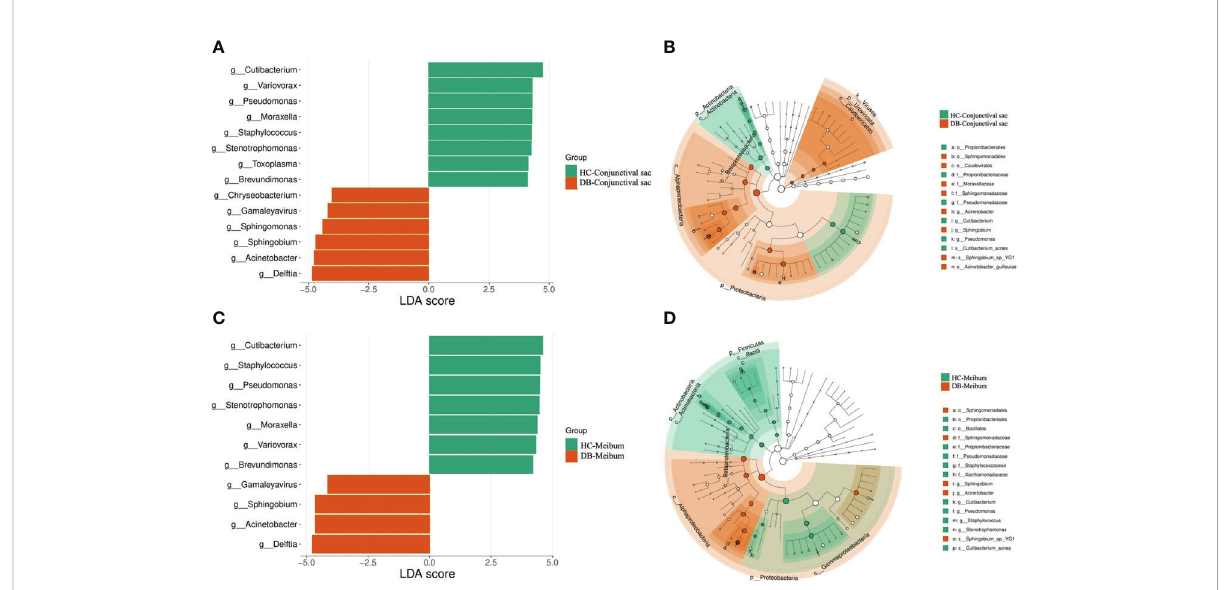
FIGURE 4 Bacterial biomarkers identi fi ed with the linear discriminant analysis effect size (LEfSe) algorithm. Linear discriminant analysis (LDA) scores with the LEfSe tool for taxa, with LDA scores>4 and p<0.05 shown in the histogram (A, C) . Cladogram displaying the relations between taxa at different taxonomic levels (B, D) . Each circle represents a hierarchy, followed by phylum, class, order, family, and genus. Different phyla are marked with different colors. The size of the nodes represents the taxon abundance. HC, Healthy control; DB, Demodex